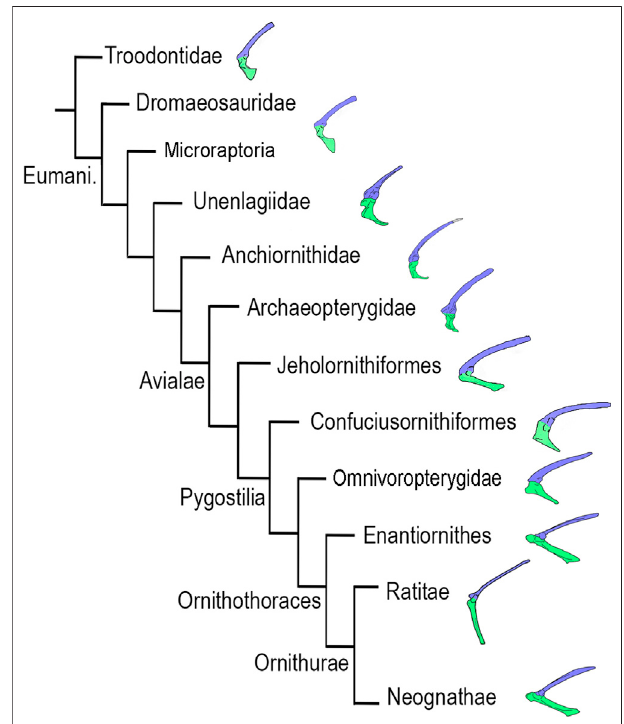
FIGURE 1 | Phylogenetic framework following Agnolín and Novas (2013); see also Agnolín and Novas, 2011; Agnolín et al., 2019; Motta et